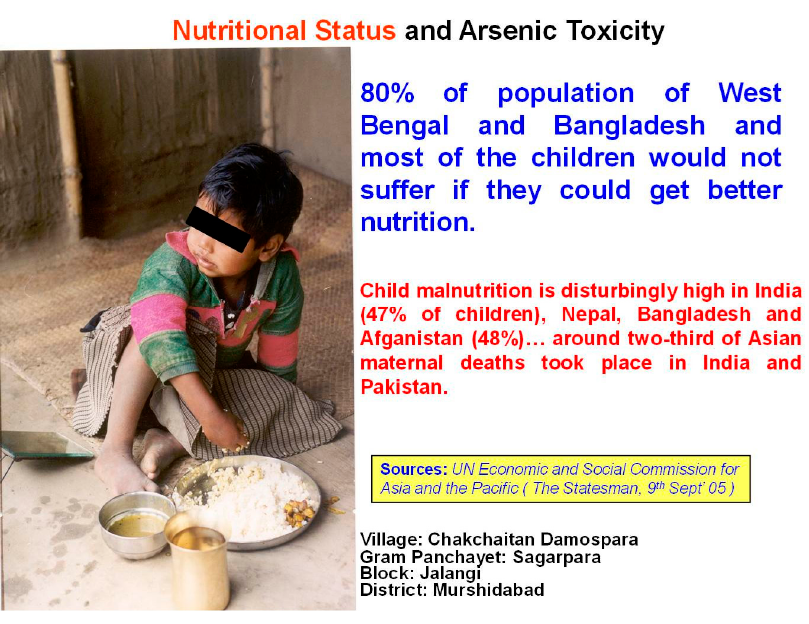
Figure 7. Malnutrition. Figure 7.